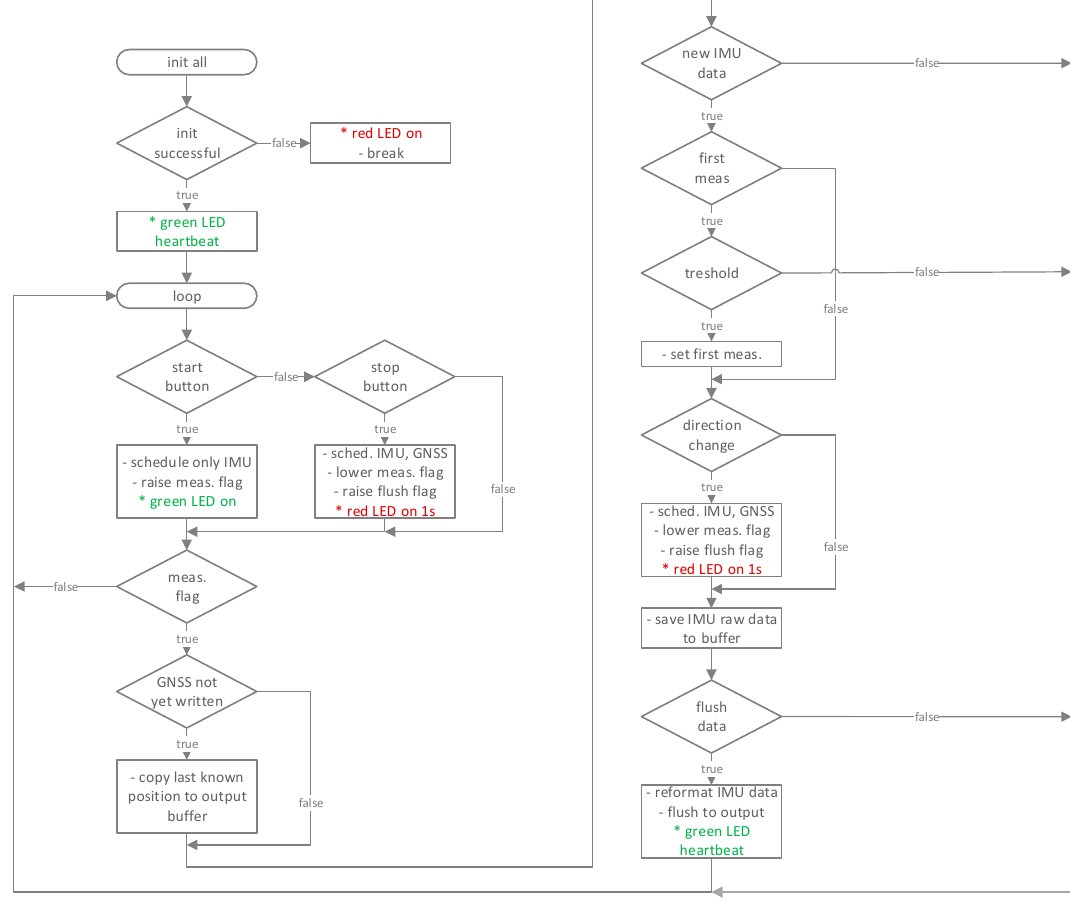
Figure 4. Measurement application program flow.